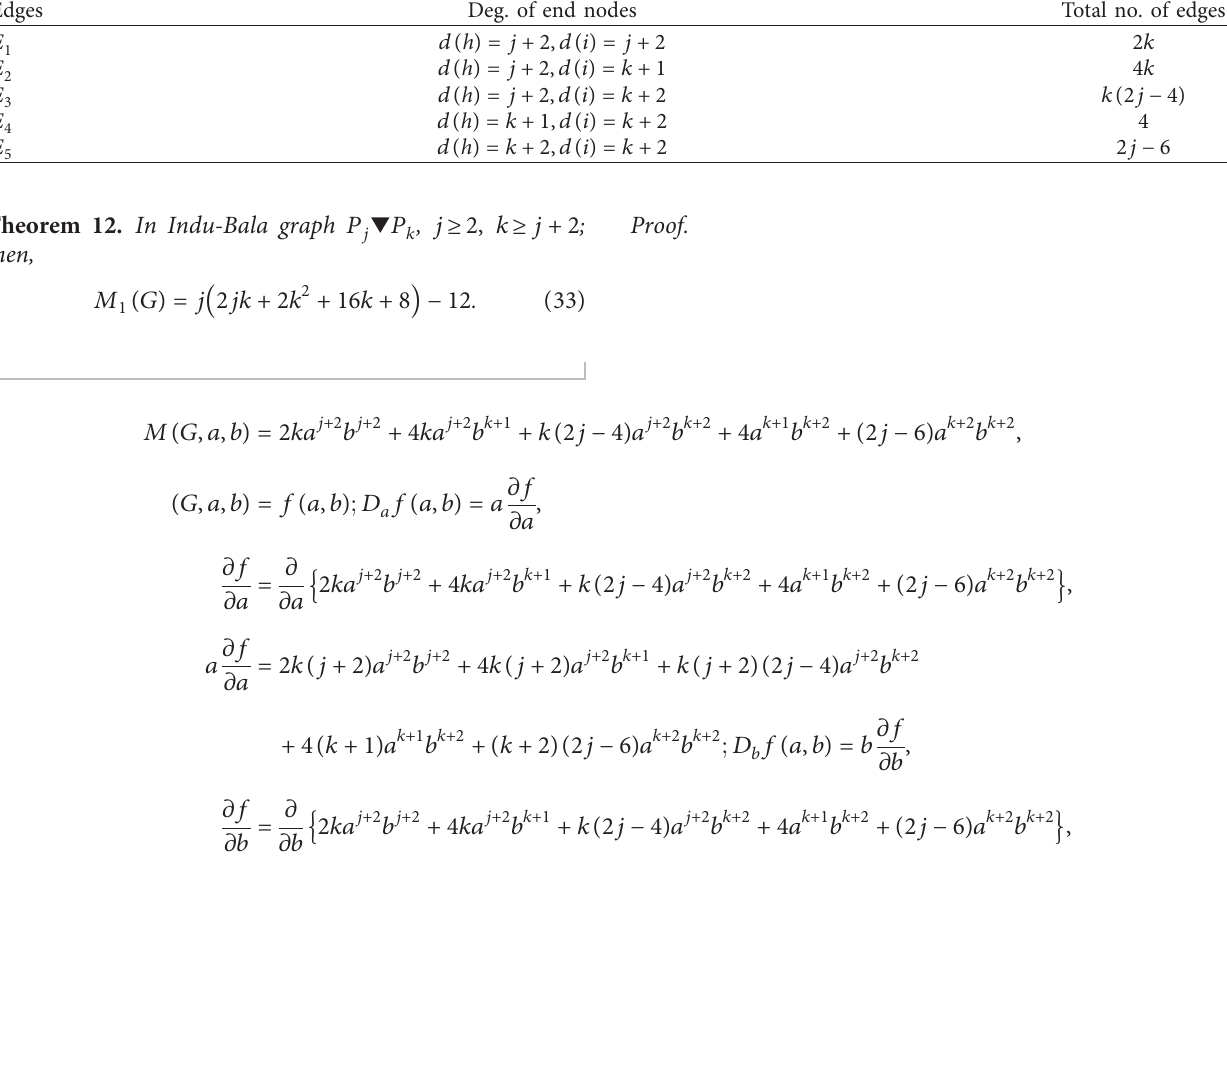
Table 4: Points of edge partitioning of P